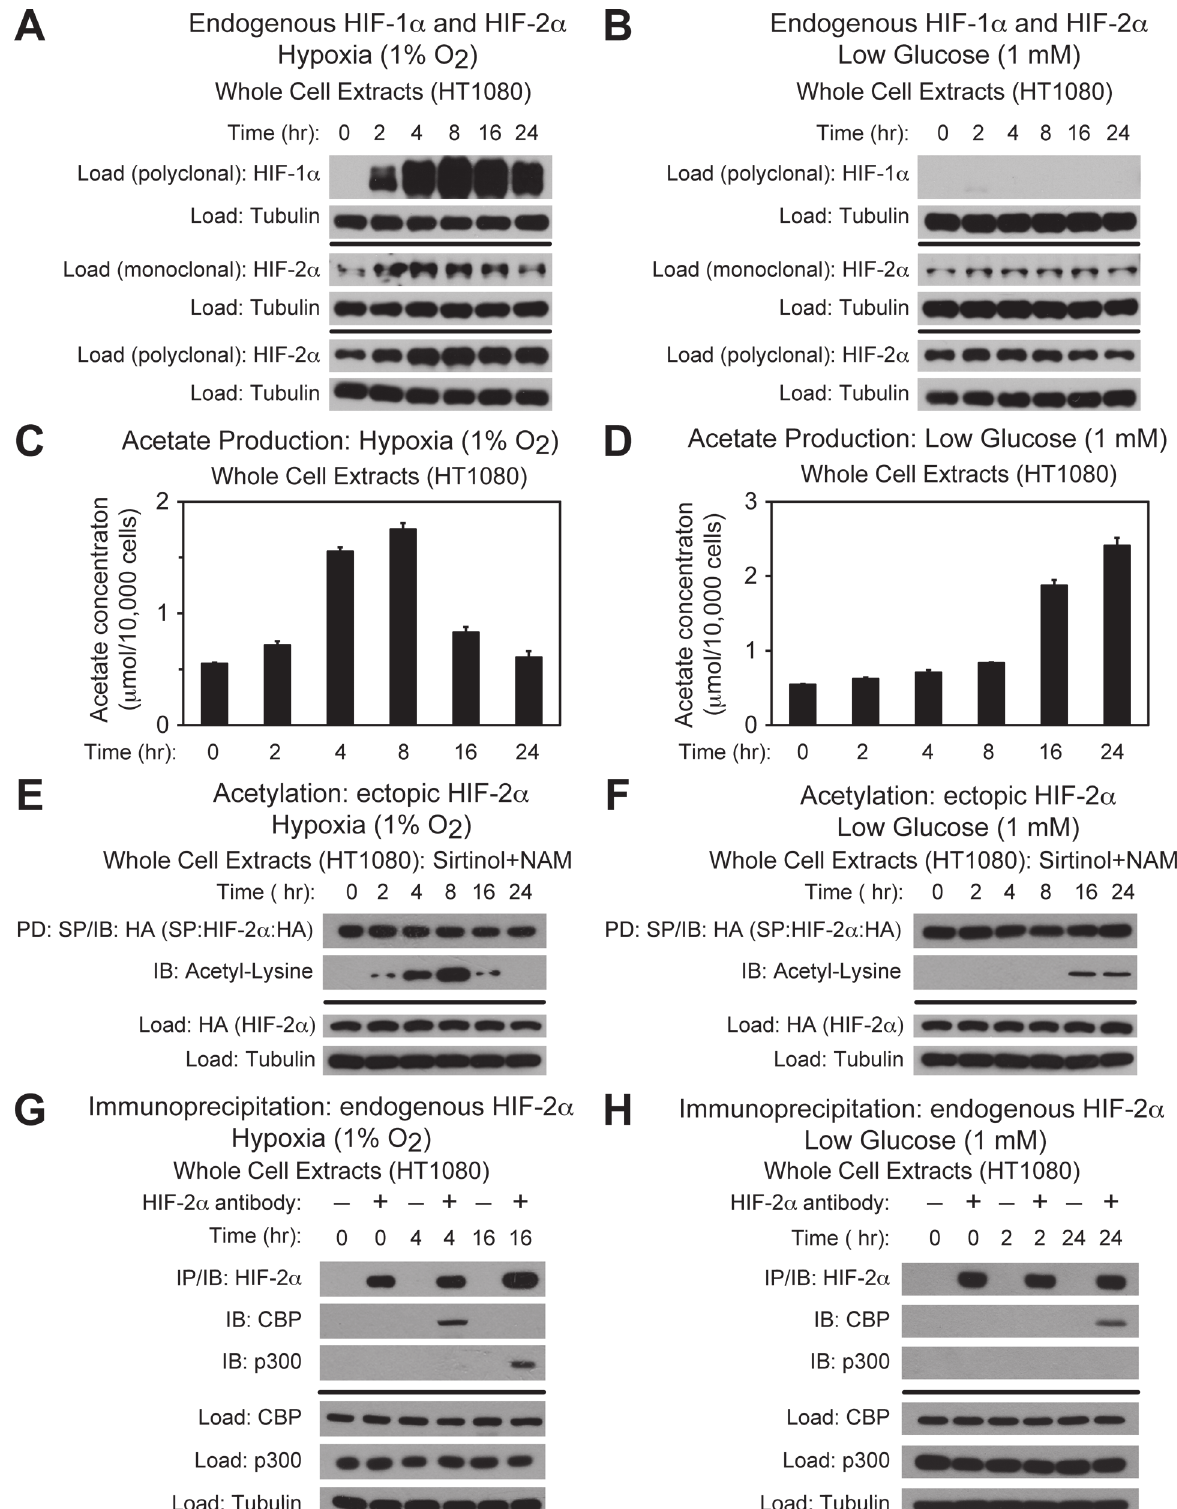
Fig 1. Acetate controls CBP/HIF-2 α interactions during stress. (A) Detection of endogenous HIF-1 α or HIF-2 α in whole cell extracts by immunoblotting after the indicated period of hypoxia exposure. Alpha-tubulin levels for each immunoblot are also shown. (B) Same as (A) except after low glucose exposure.